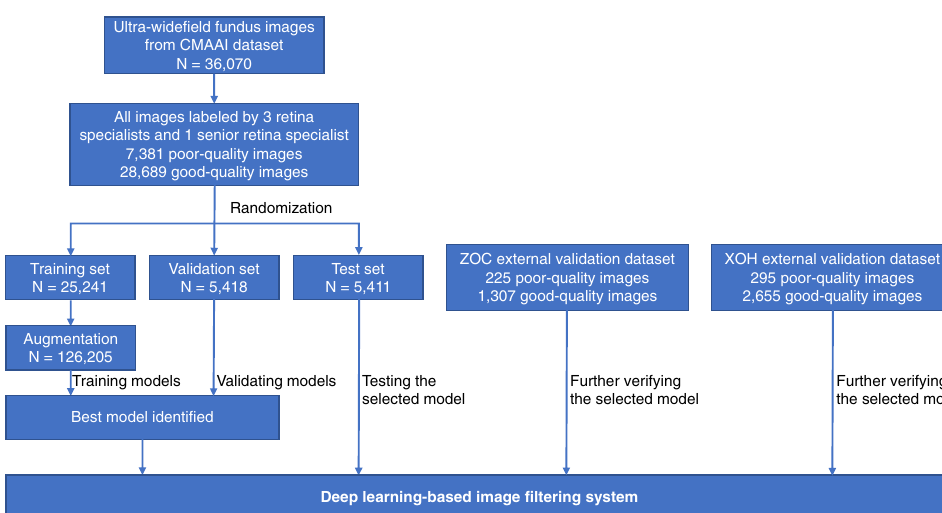
Fig. 1 Process of developing and evaluating the deep learning-based image fi ltering system based on ultra-wide fi eld fundus images. CMAAI Chinese Medical Alliance for Arti fi cial Intelligence, XOH Xudong Ophthalmic Centre, ZOC Zhongshan Ophthalmic Centre.